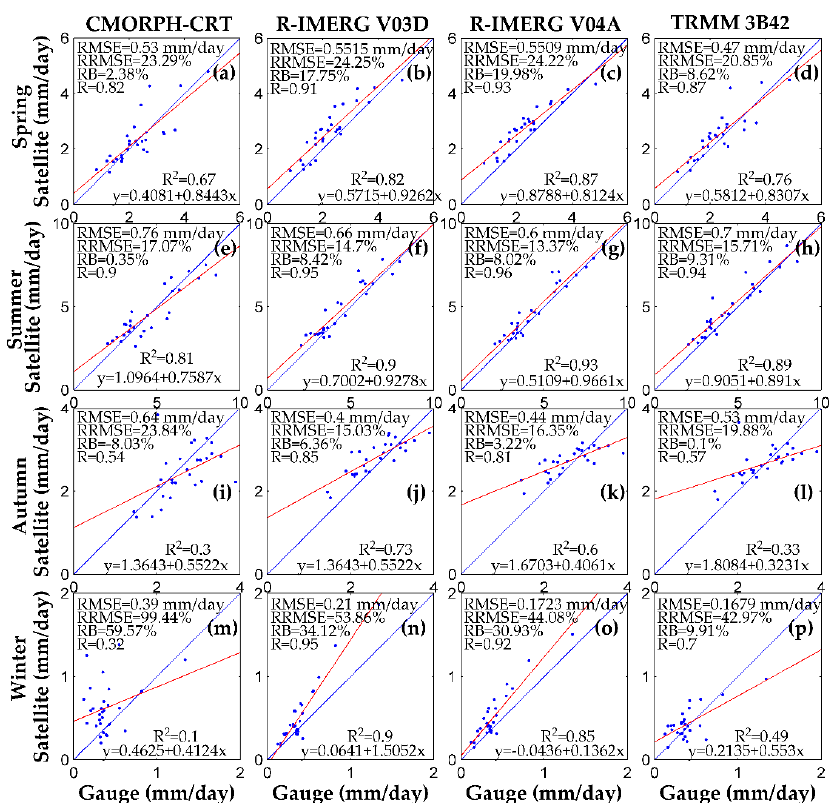
Figure 10. Scatterplots of satellite-based estimates versus gauge observations of average daily rainfall for different seasons over the Huaihe River Basin for CMORPH-CRT ( a , e , i , m ), R-IMERG V03D ( b , f , j , n ), R-IMERG V04A ( c , g , k , o ), and TRMM 3B42 ( d , h , l , p ).